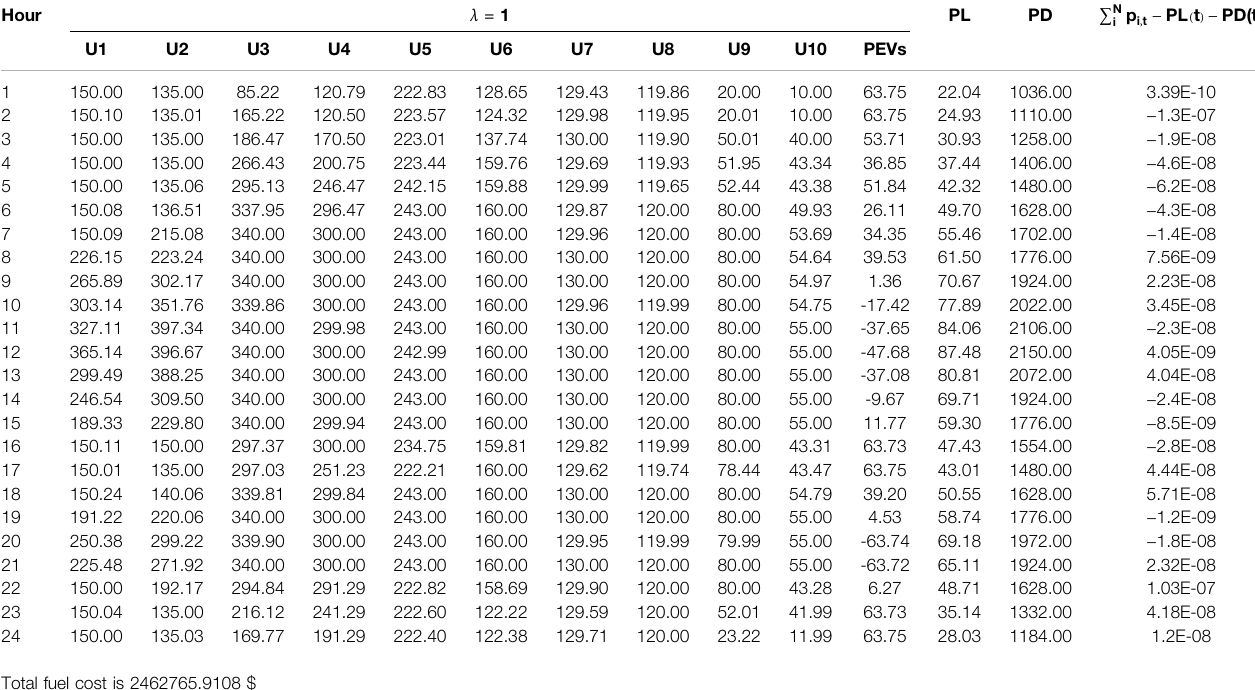
TABLE 14 | The optimal solution information for Case VI : the 10 units with orderly